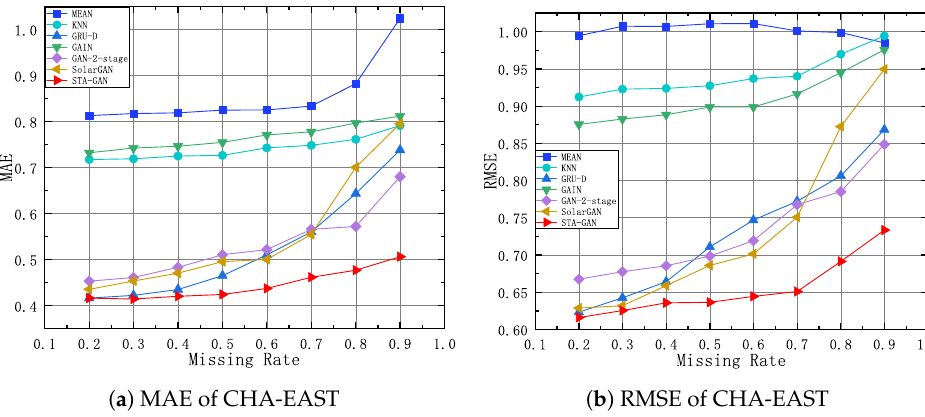
Figure 14. MAE and RMSE of CHA-EAST dataset with different missing